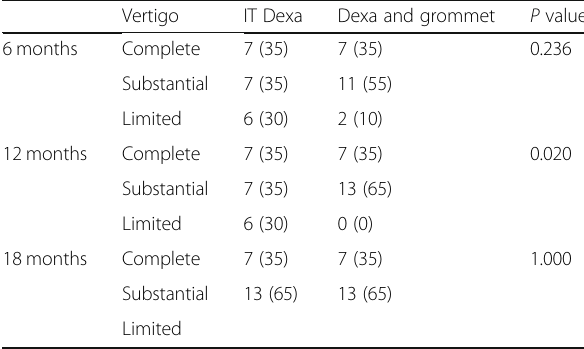
Table 3 Comparing the groups IT Dexa and Dexa through grommet regarding control of vertigo by chi-square test